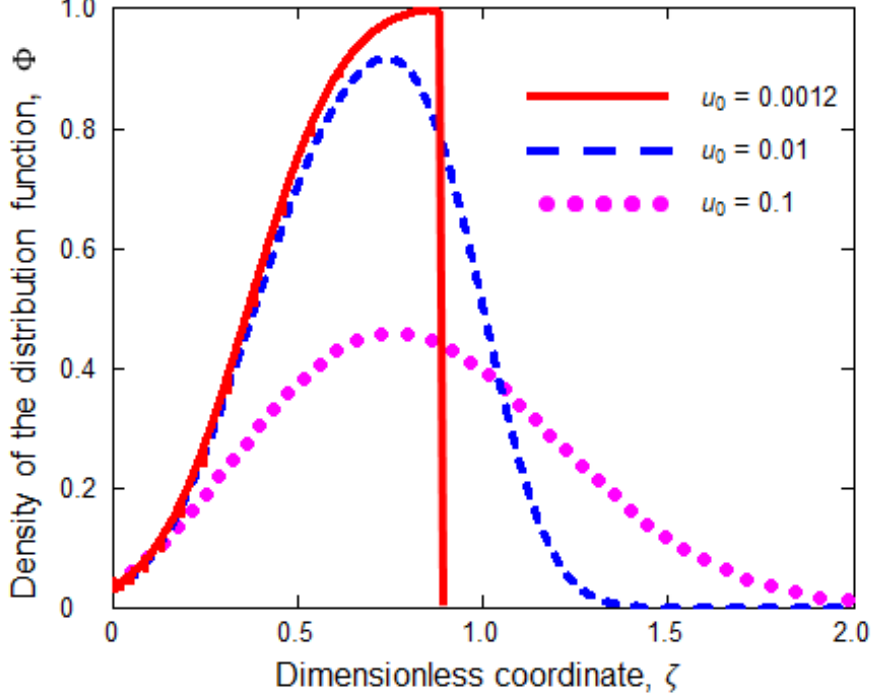
Figure 6. The dimensionless density of the distribution function Φ as a function of the crystal radius at different values of the parameter u 0 ( ξ =